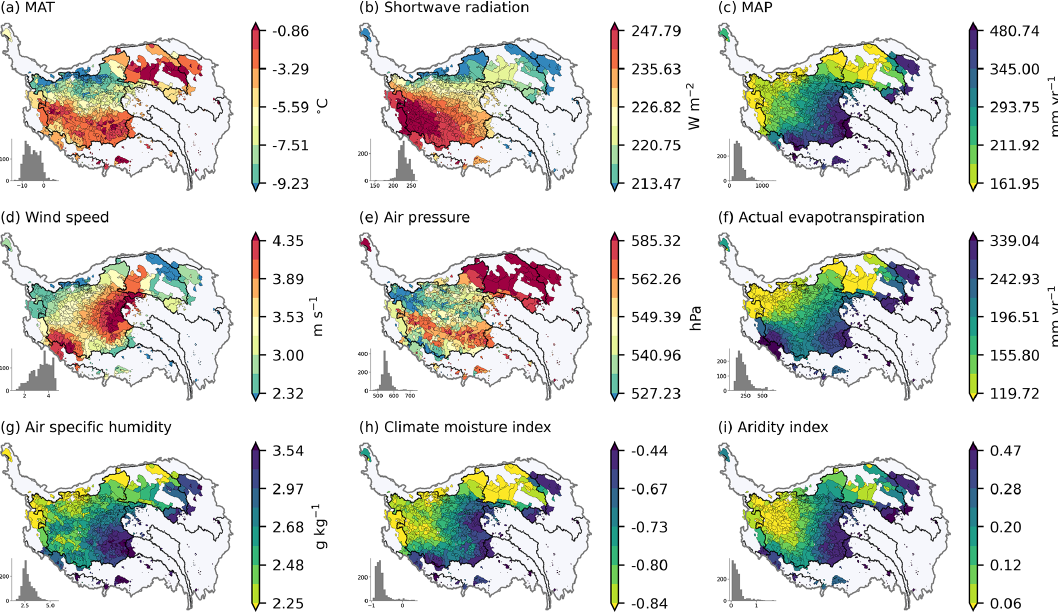
Figure 8. Spatial distribution of multi-year average climatic characteristics for inter-lake catchments on the TP. MAT represents mean annual temperature, and MAP represents mean annual